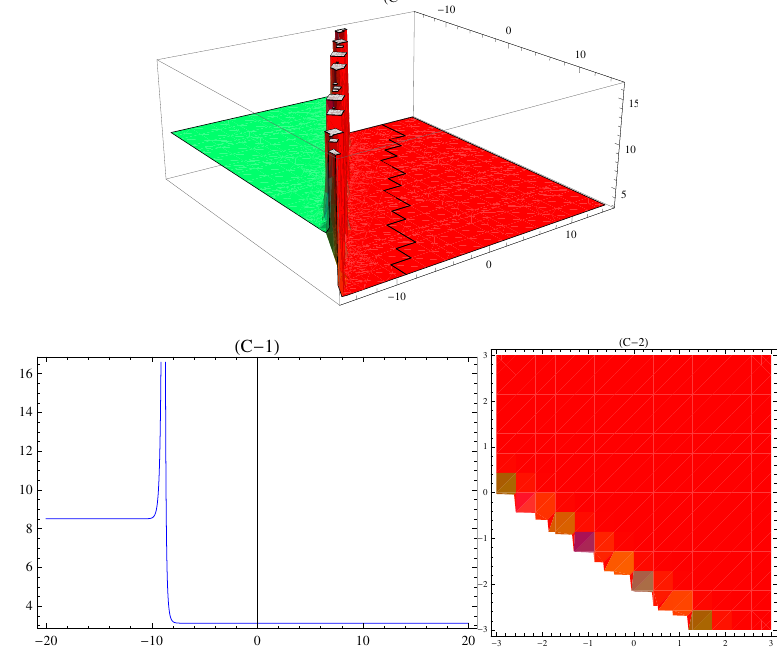
Figure 3: (C) 3D graph of (29) with α = 2.3 , 𝛾 = 1.5 , Θ = 2.1 , λ = 3.4 , µ = 1.7 , w = 2 , p = 0.98 , q = 0.95 , k = 2 , A = 2.3 , δ = 2 , ς = 1.9 , τ = 0.85 , c = 4 , z = 3 , χ = 2.6 , ϵ = 3 , y = 2.6 . (C-1) 2D plot of (29) with t = 1 . (C-2) Contour graph of